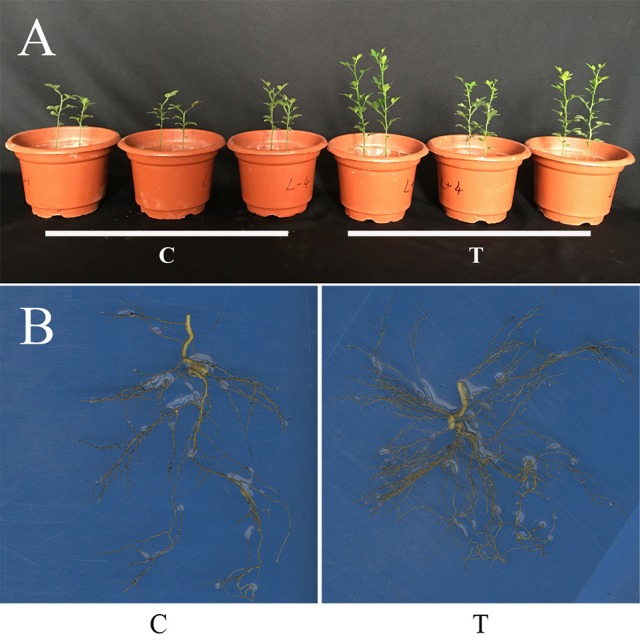
Plant growth of trifoliate orange seedlings as affected by AMF inoculation. (A) Photo showing the overall plant growth; (B) The root systems. C: non-mycorrhizal treatment, T: mycorrhizal treatment.